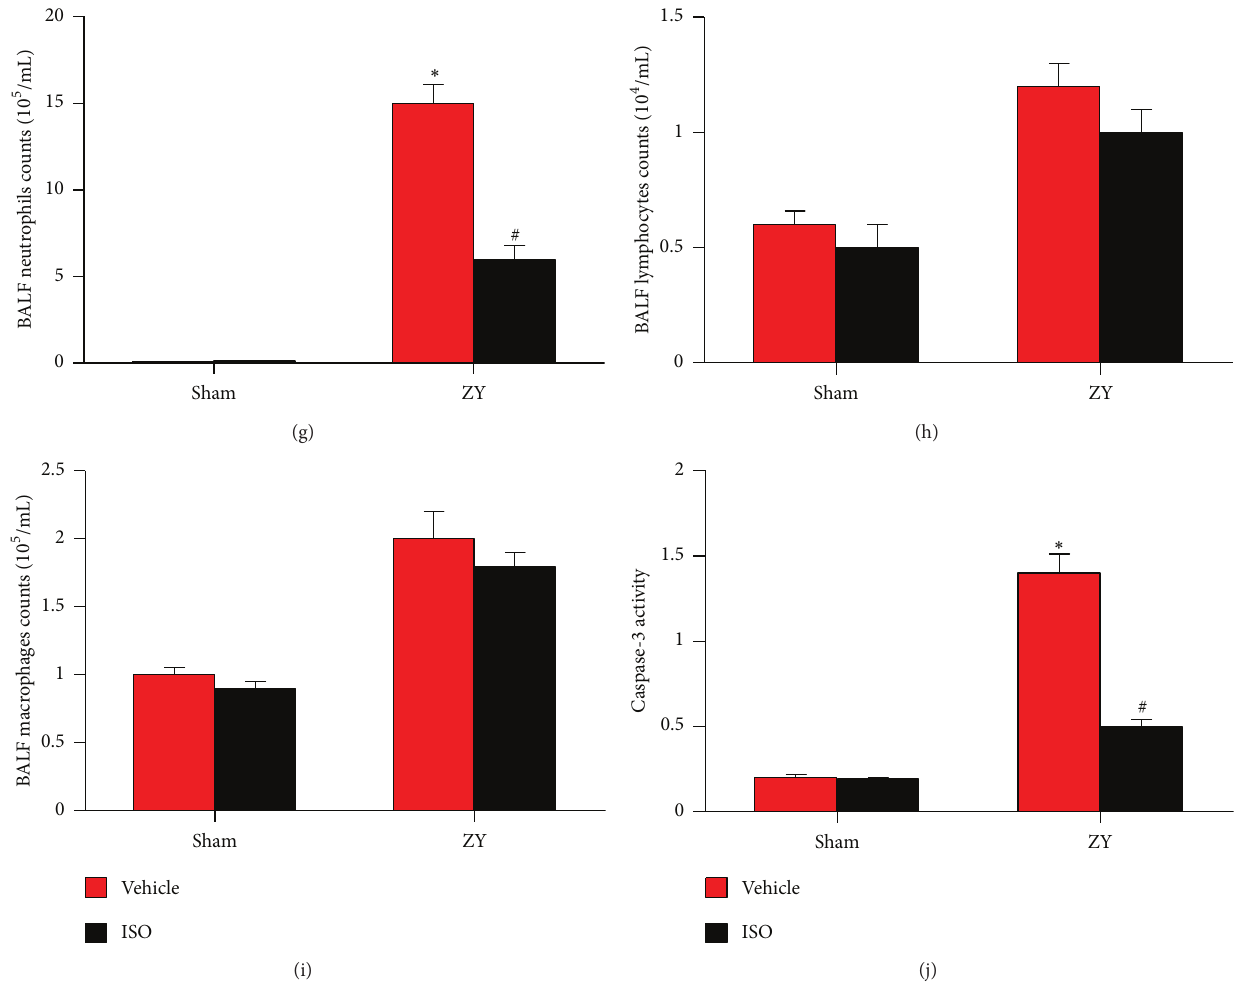
Figure 2: Treatment with 1.4% ISO attenuates lung damage in ZY-challenged mice. (a) Body weight change, (b) survival rate, (c) HE examination of lung (400x magnification), (d) lung histologic scores, (e) lung W/D ratio, (f) BALF total cell counts, (g) BALF neutrophil count, (h) BALF lymphocyte count, (i) BALF macrophage count, and (j) caspase-3 activity. The animals were treated as described in Figure 1. Data are mean ± SD ( 𝑛 = 10 mice per group). ∗ 𝑃 < 0.05 versus sham; # 𝑃 < 0.05 versus ZY +